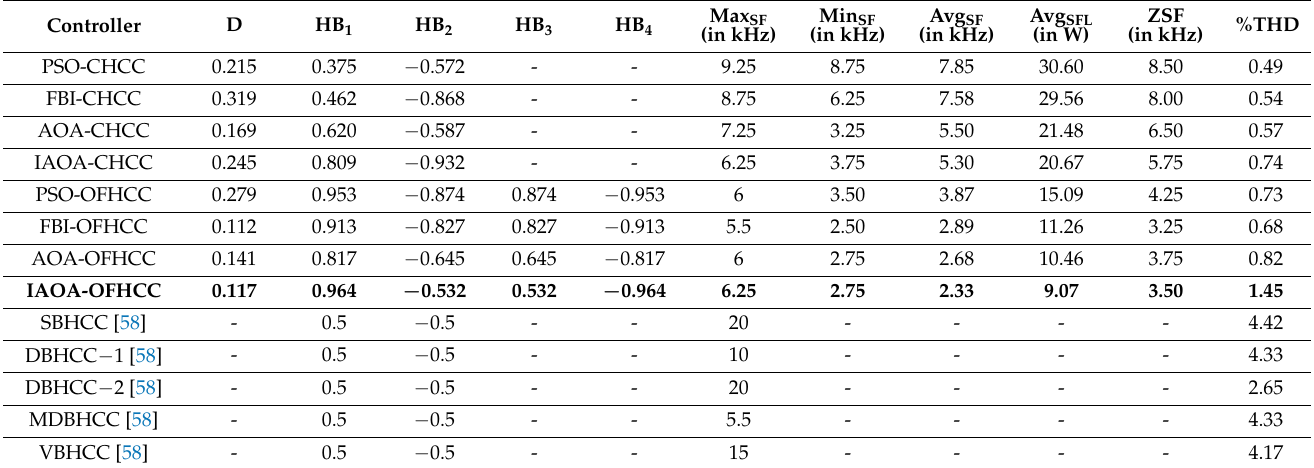
Table 4. Performance analysis of various controllers.